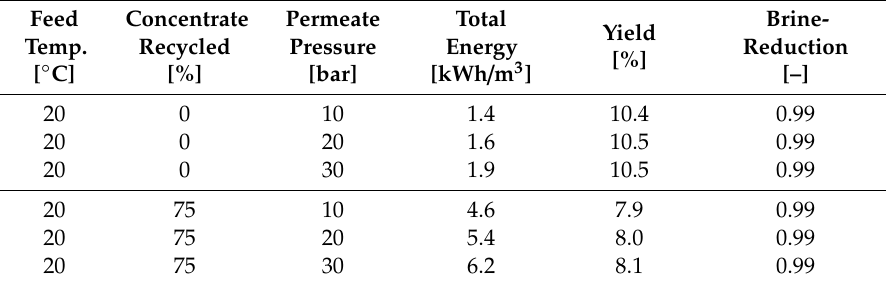
Table 13. Optimized results of SW30XLE-440i membrane at 20 ◦ C.